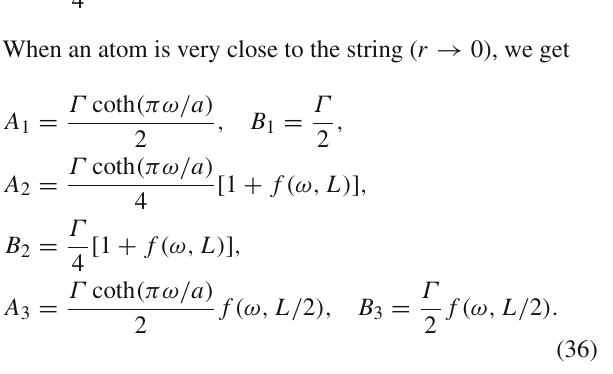
Fig. 2 Entanglementasfunctionof Γ τ withdifferentaccelerationsfor initial Werner state with p =2/3, ν = 2, ω L = 1 and ω r = 1 Γ [ f (ω, L / 2 ) + f (ω, L / 2 + r ) ] B 3 = 4